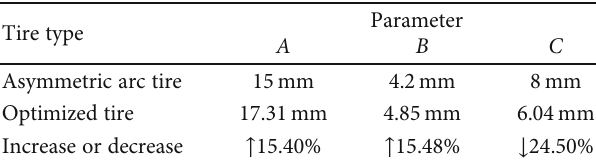
Table 7: The comparison of spoke parameters.